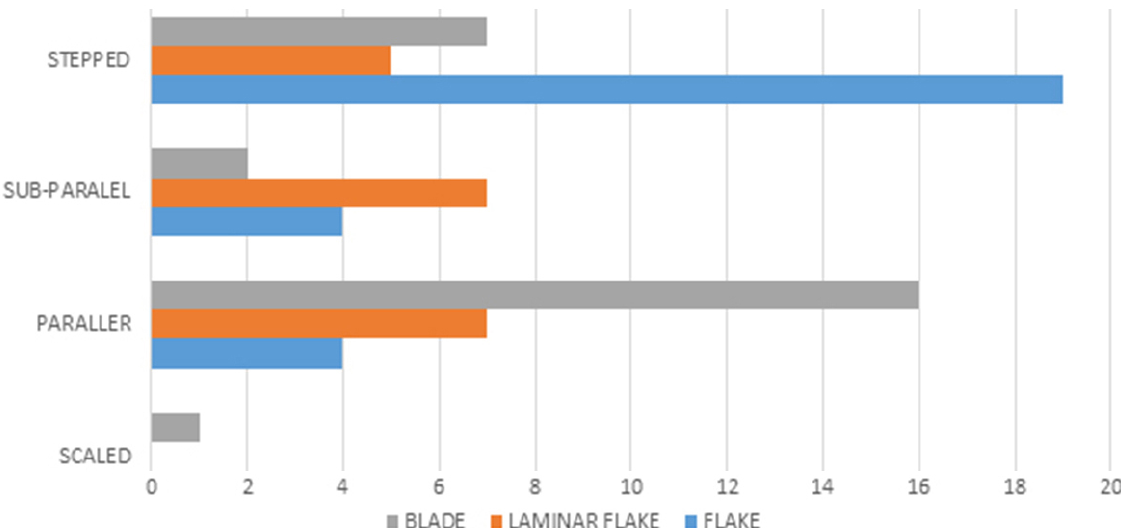
Figure 13. Representation of the morphology of the retouch from the retouched